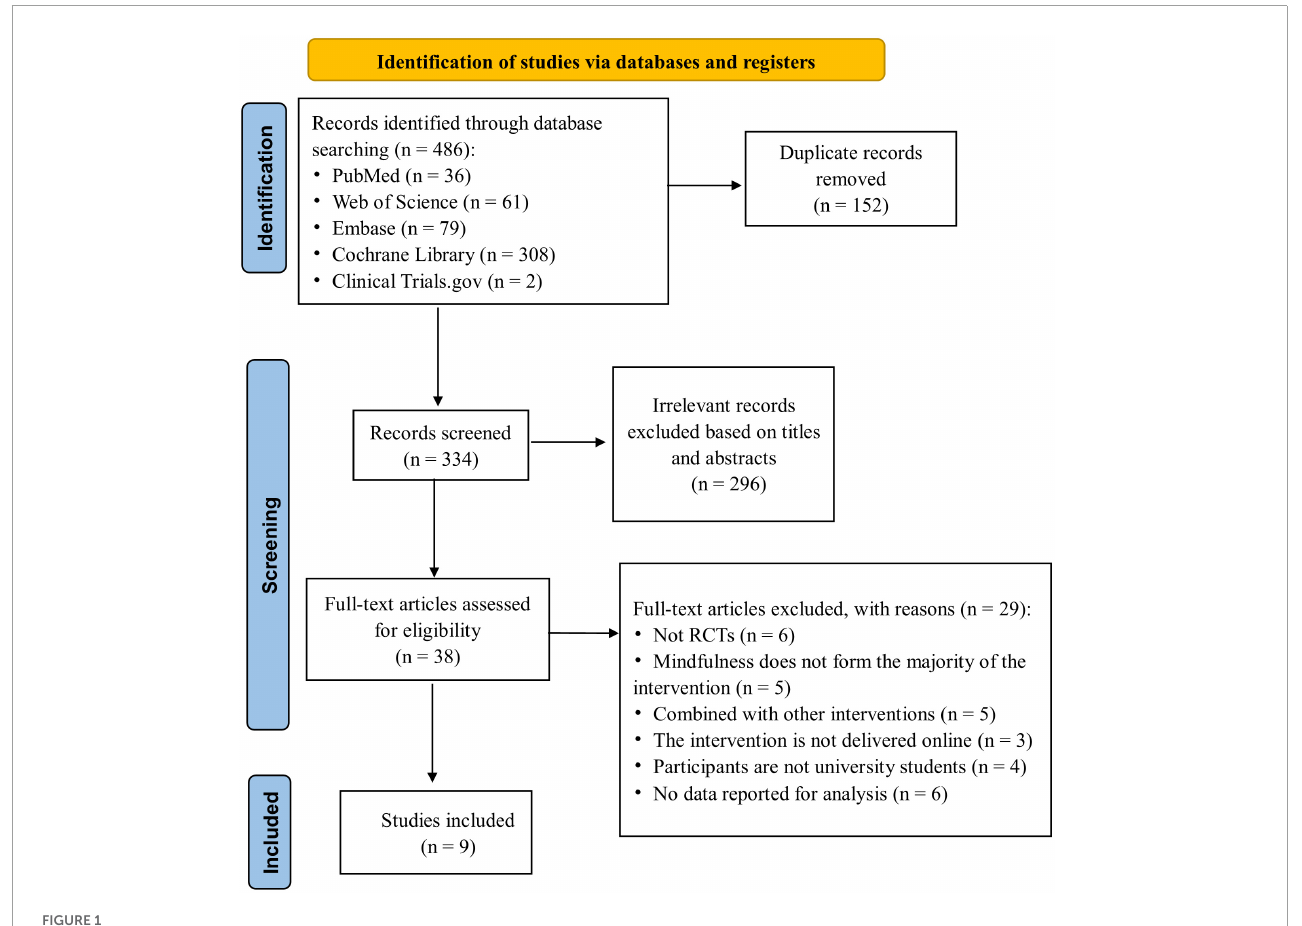
FIGURE1 Flow chart of study